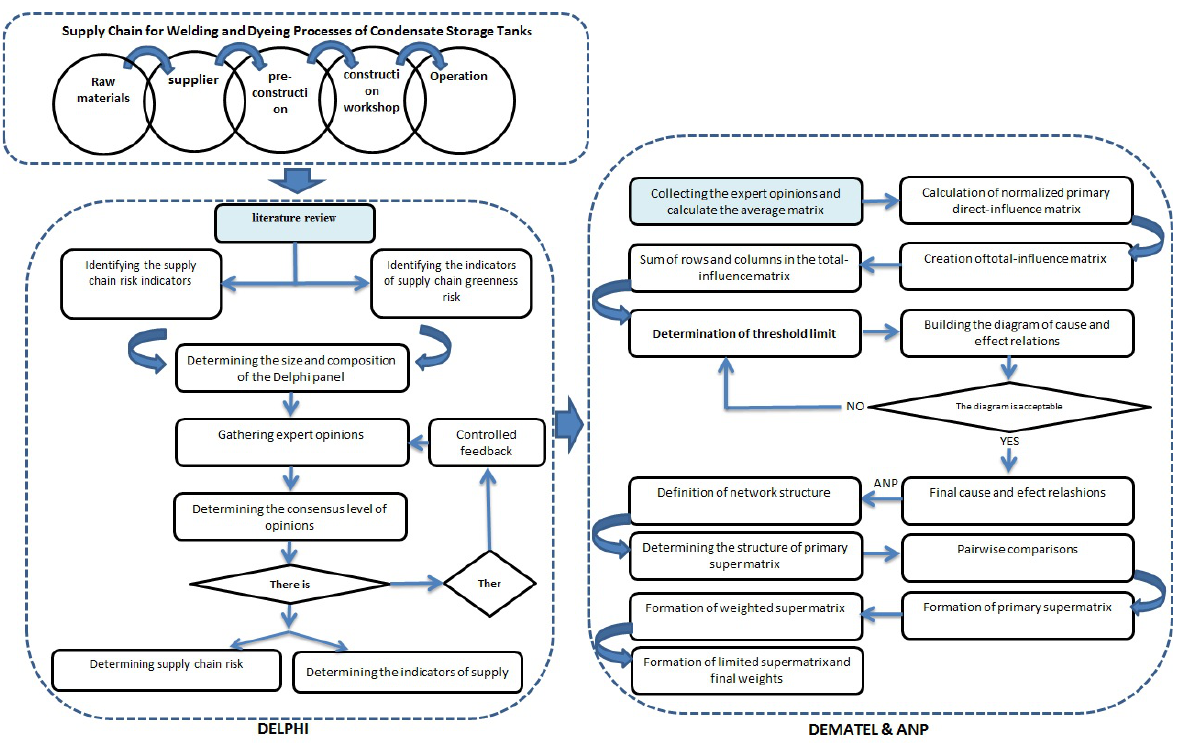
Figure 2. Executive process of the research Here provides a description on the research